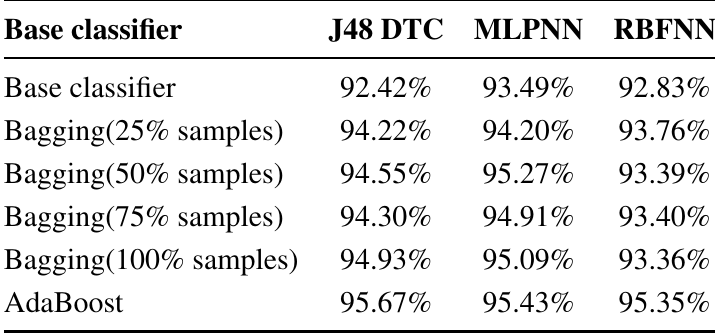
Table 4. Accuracy of AdaBoost and Bagging using different base